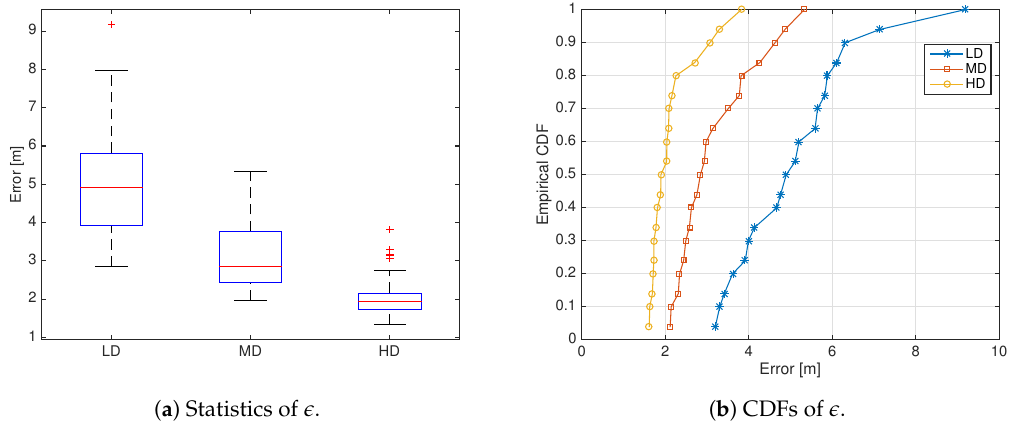
Figure 7. Statistics ( a ) and cumulative distribution functions (CDFs) ( b ) of the positioning error (cid:101) in low, medium and high density (LD, MD and HD) scenarios for the WiFi-opt system.